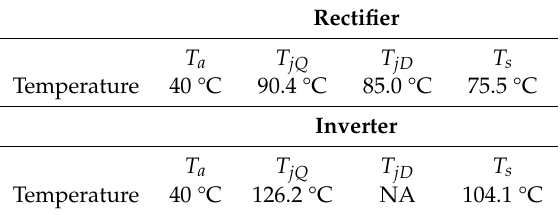
Table 4. Temperatures calculated using the thermal models from the Figures 4 and